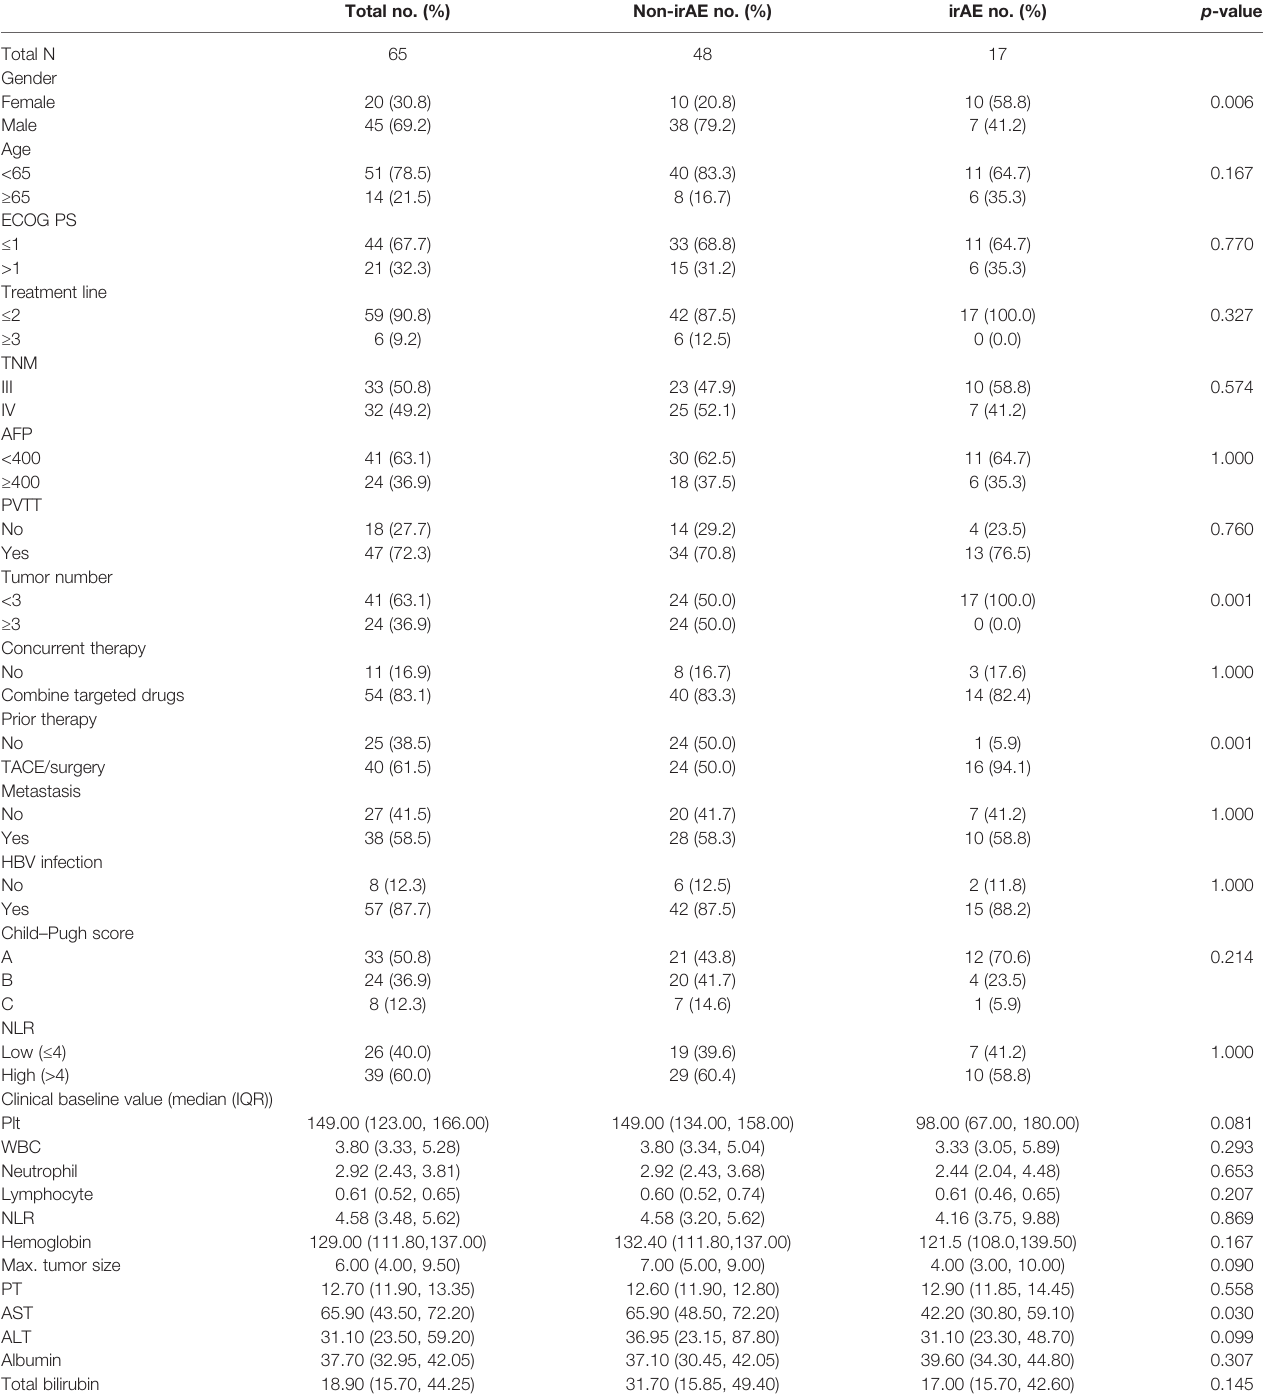
TABLE 1 | Characteristics of patients in irAE and non-irAE groups. Total no. (%) Non-irAE no.